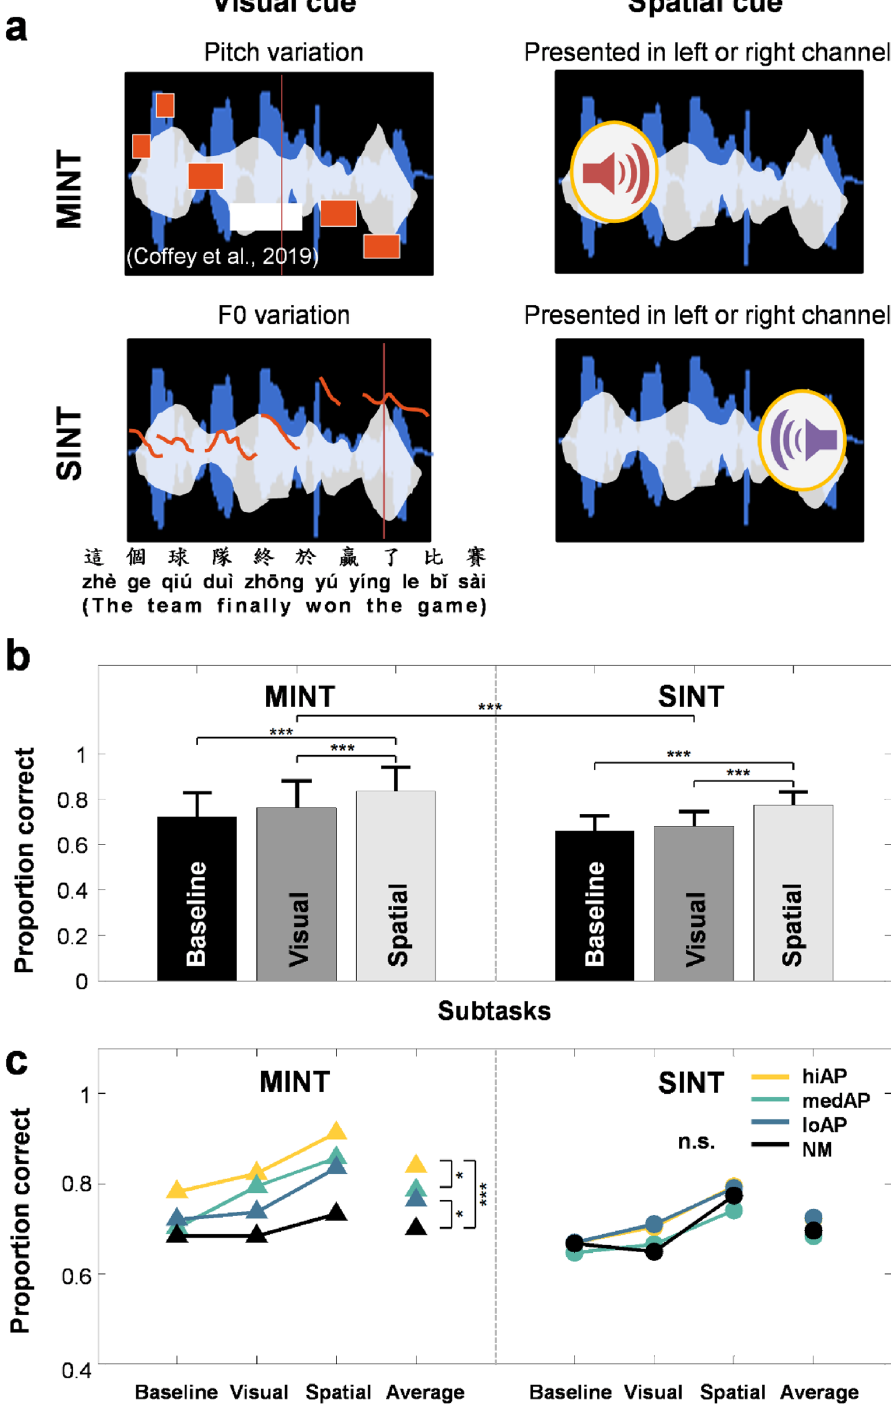
Figure 4. Performance accuracy on MINT and SINT subtasks. ( a ) Schematic depiction of the visual and spatial subtask for MINT (top panels) and SINT (bottom panels). Visual cue is represented as pitch variations (red) for melodic targets (blue) and F0 variations (red) for speech targets (blue). Spatial cue is represented as a speaker positioned to indicate left or right. Masking noise is represented in white. ( b ) Mean proportion correct for baseline, visual and spatial subtasks for MINT and SINT. ( c ) Mean proportion correct of the baseline, visual and spatial subtasks for MINT and SINT as a function of quasi-AP-proficiency groups. Error bars represents ± 1 SD. ***p < 0.001, **p < 0.01, *p < 0.05 level of significance; n.s. not